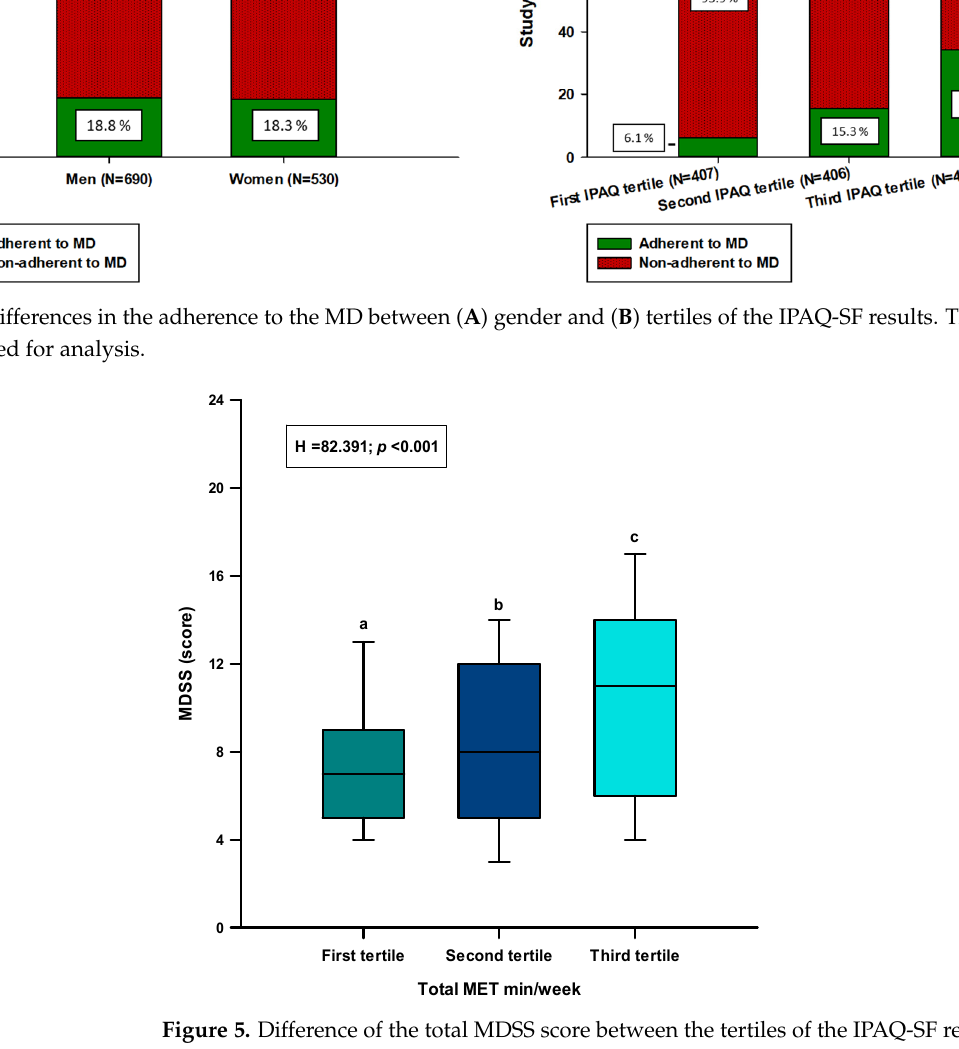
Table 4. Multiple linear regression model of the independent predictors of the total MDSS score. Variable.